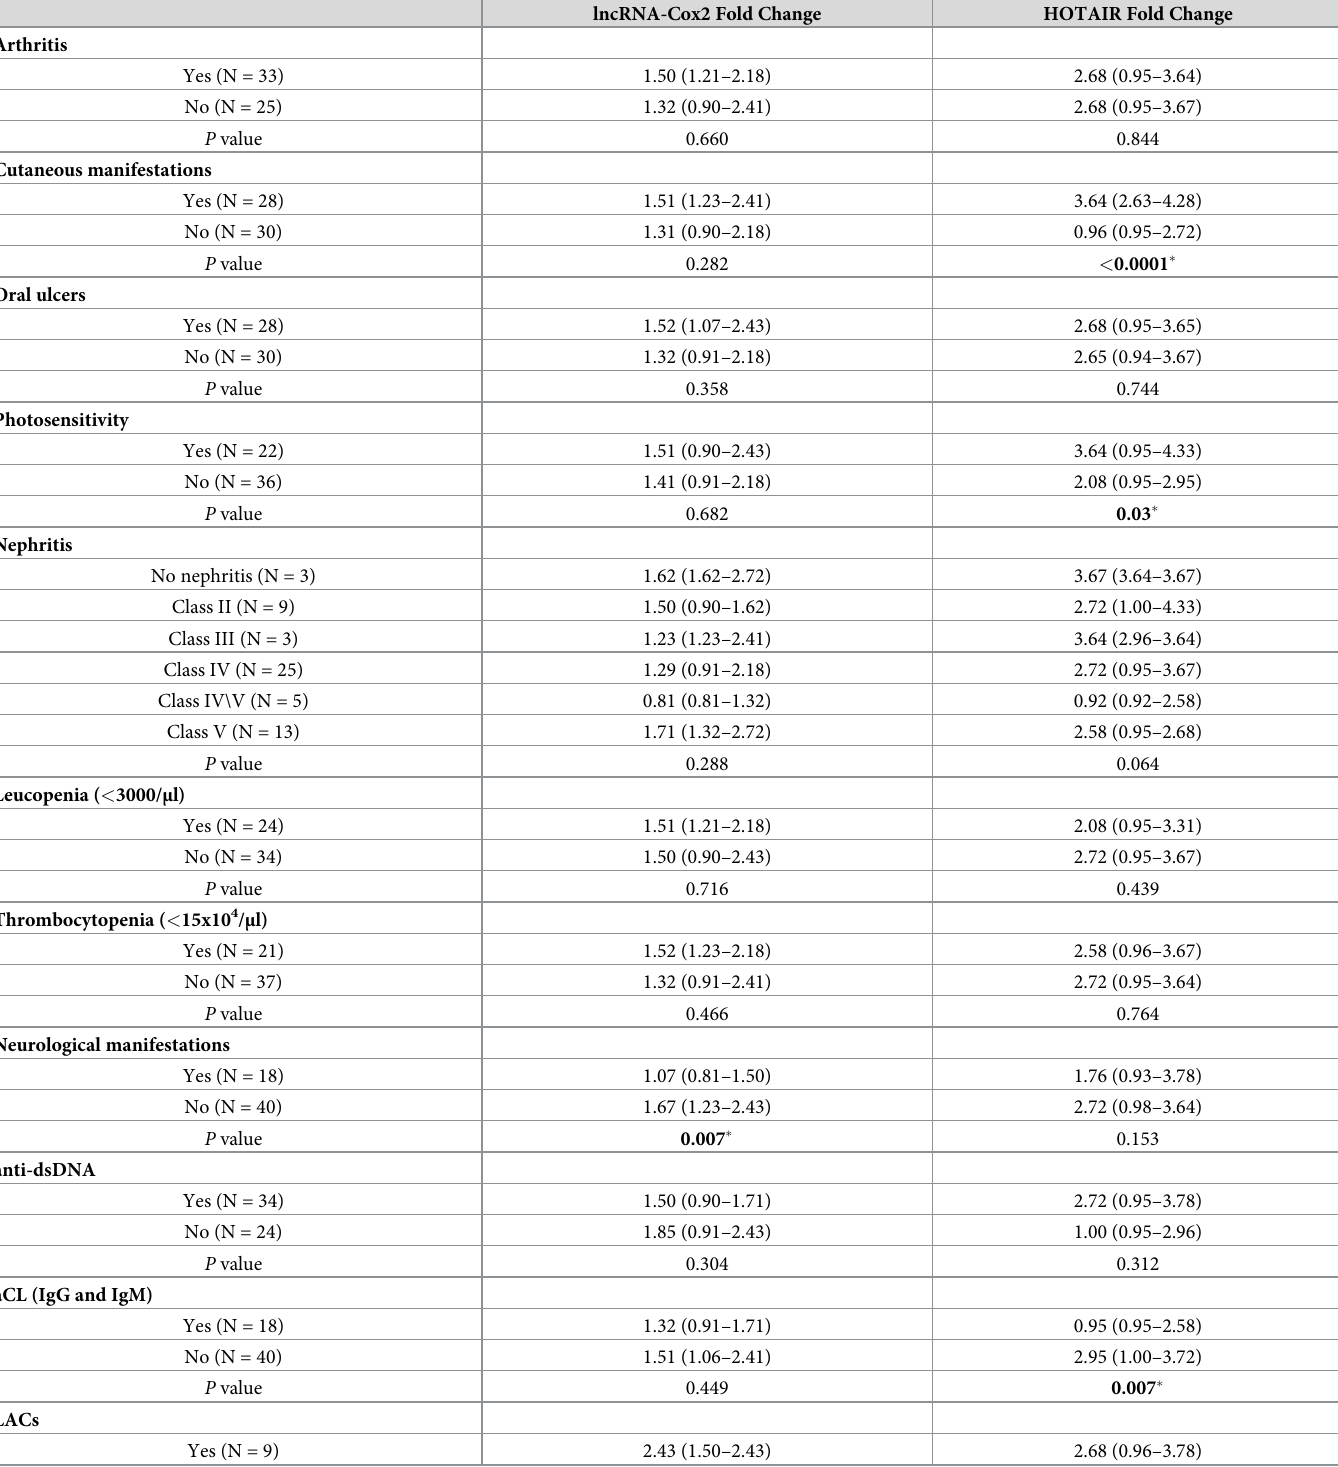
Table 2. Relation between serum lncRNA-Cox2 and HOTAIR levels and clinical manifestations and laboratory findings in systemic lupus erythematosus (SLE)